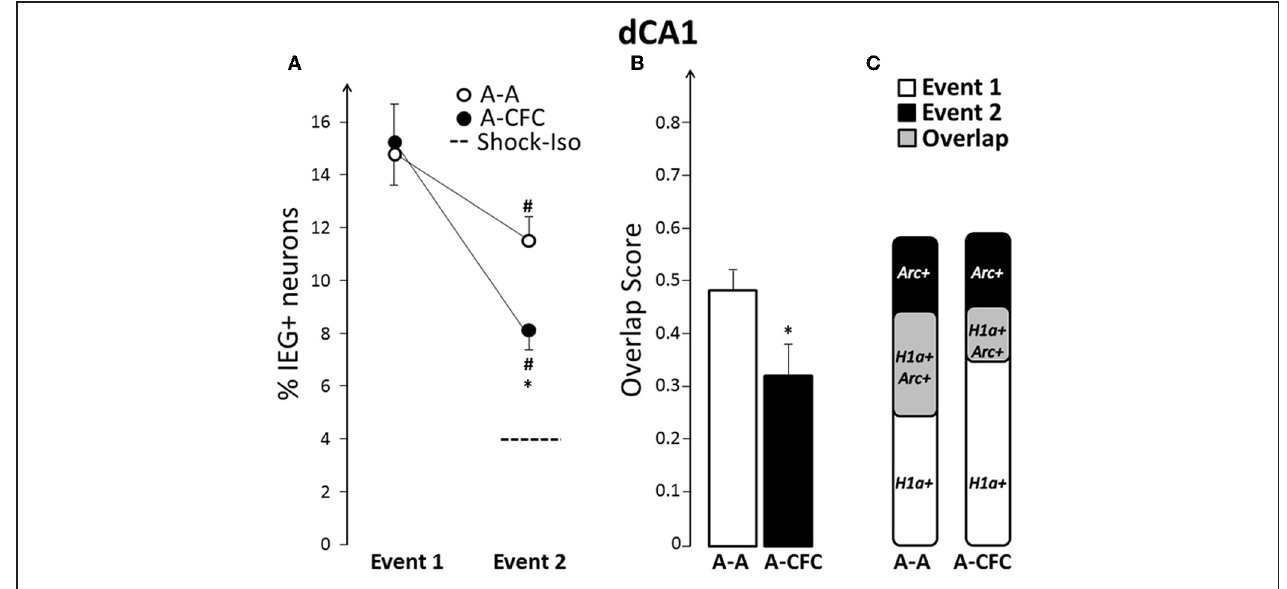
FIGURE 3 | Comparison of ensemble size and overlap between dCA1 ensembles activated during both events in A-A and A-CFC groups: (A) Size of IEG-expressing ensembles expressed as percentage of total cells. The dashed line is the percentage of dCA1